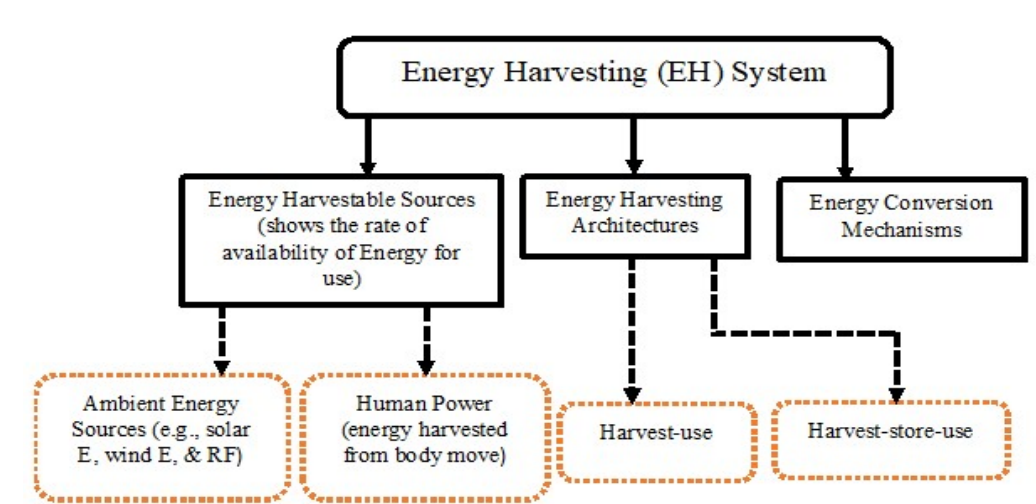
Figure 1. Block diagram of an EH